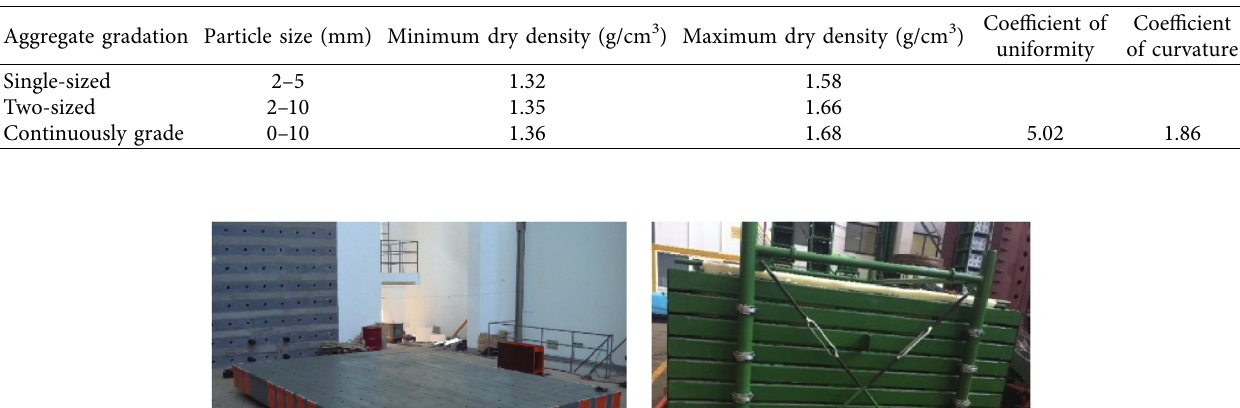
Figure 2: Three gravel aggregates of different gradations. (a) Single-sized aggregates. (b) Two-sized aggregates. (c) Continuously graded aggregates. Table 2: Physical properties of three gravel aggregates of different gradations.